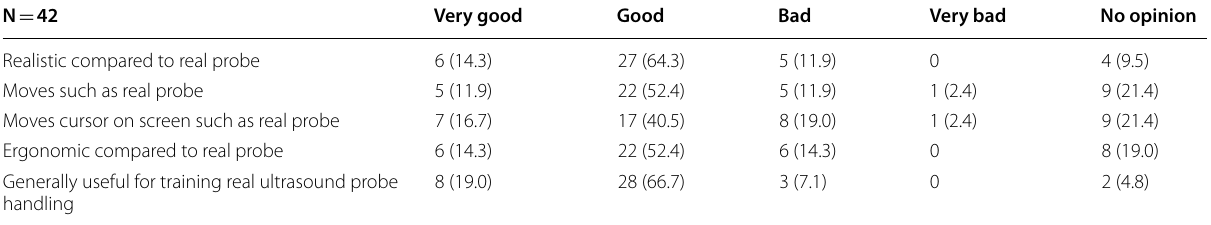
Data displayed as absolute numbers and percentages N